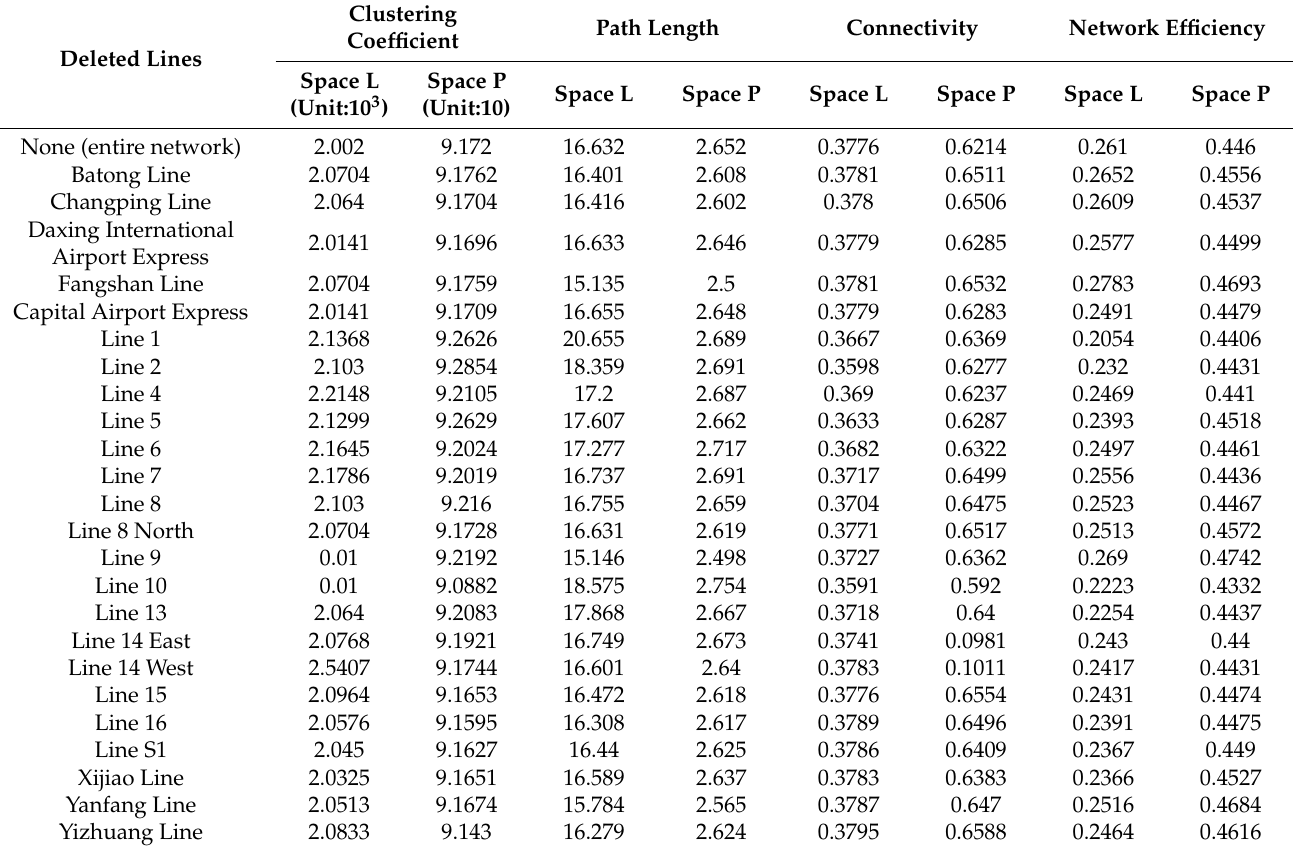
Table 10. Calculation results of the global impact